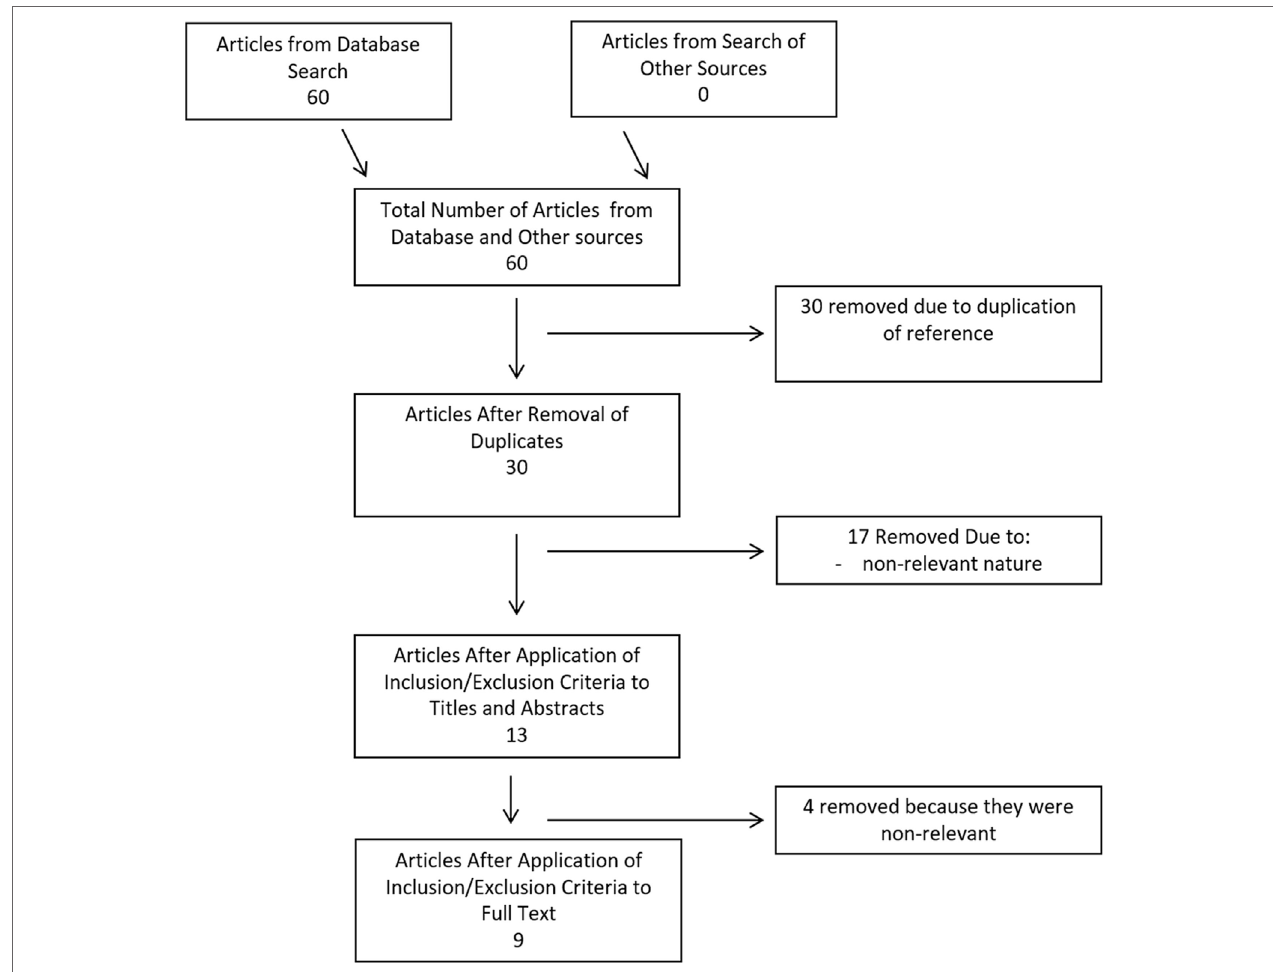
FiGURe 1 | Flow diagram of search results for cerebral microdialysate